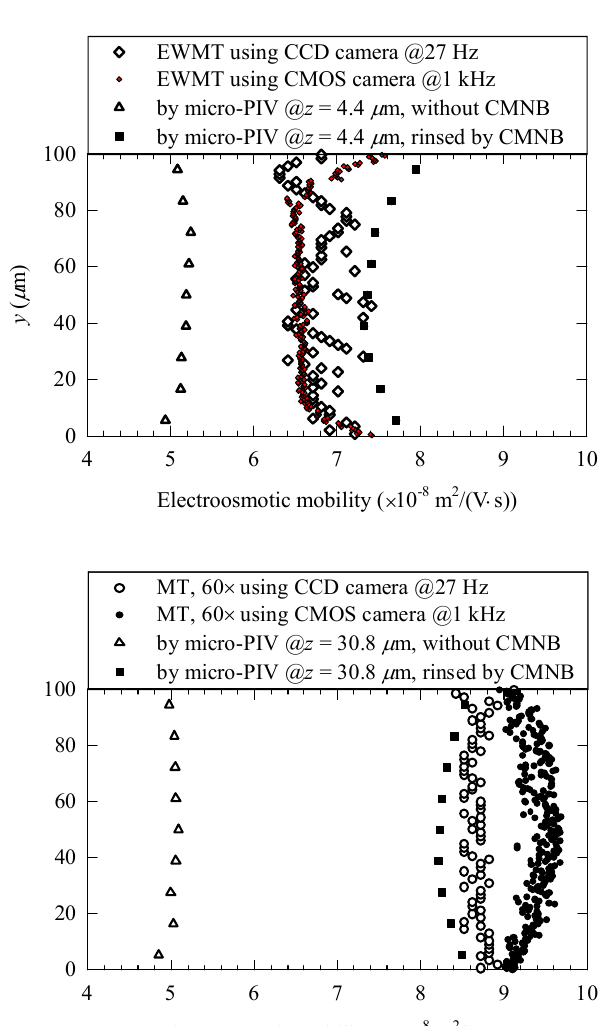
Figure 10. Electroosmotic mobility profiles in the transverse ( Y -) direction obtained from ( a ) EWMT and ( b ) MT by volume illumination with the 60 × objective lens in comparison with the measurement results by